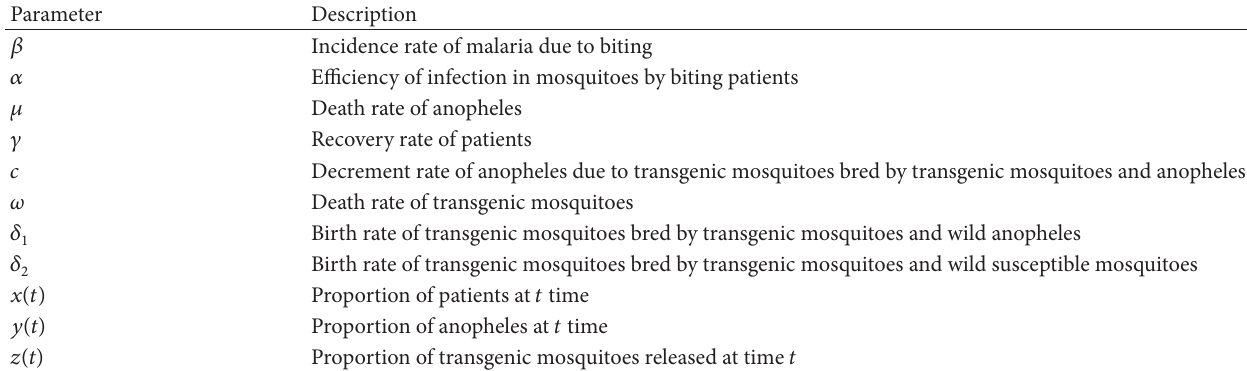
Table 2: Description of the parameters in system